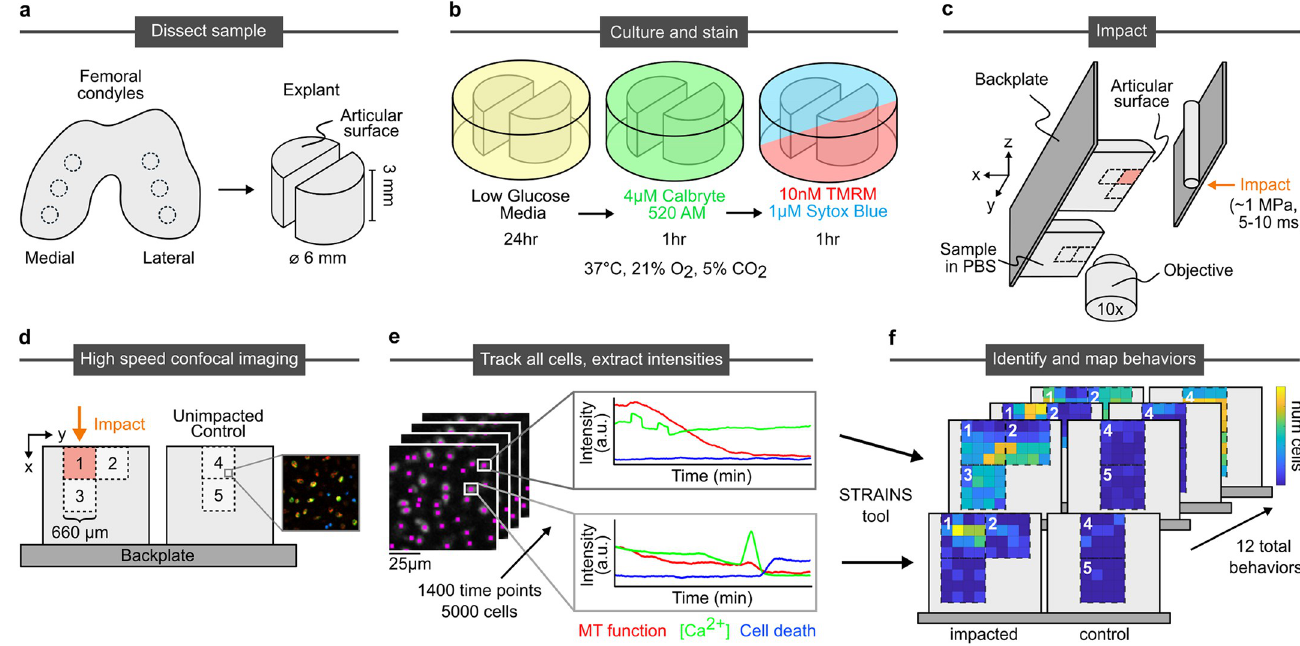
Fig 1. Sample processing, imaging, tracking, and intensity analysis procedure. a) Biopsy punches of condylar articular cartilage are collected and bisected. b) Hemicylinders are cultured and stained for calcium concentration, mitochondrial polarization, and nuclear membrane permeability (stand in for cell death). c) Samples are mounted side-by-side to the back plate of impactor. One half of the sample impacted once, with the other serving as an unimpacted control. d) Imaging occurs during impact at site 1 and after impact at sites 1–5. e) Individual cells are tracked through all time points and their stain intensities extracted. f) Temporal patterns of strain intensities are classified by STRAINS into distinct categories of cell behaviors, which are identified and mapped onto tissue location.